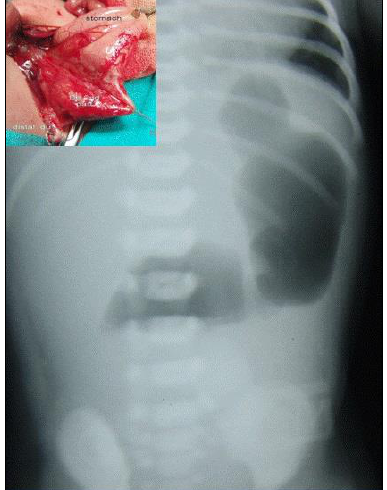
Figure 2: Double bubble sign. Inset shows duodenal atresia.